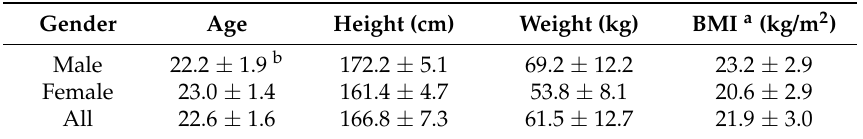
Table 1. Anthropometric information of